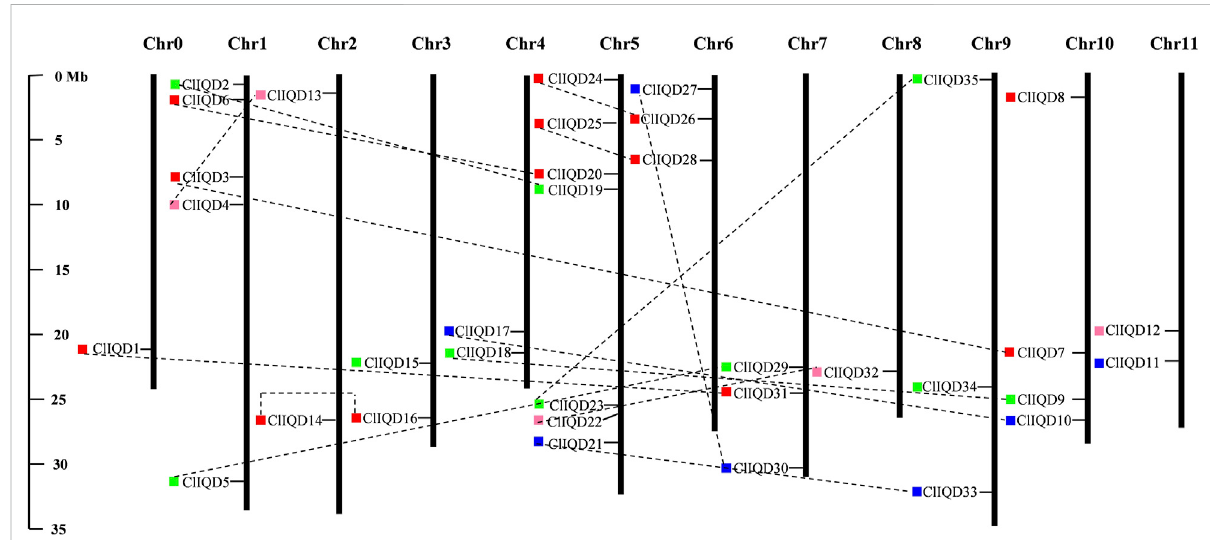
Chromosomal distribution and duplication events of watermelon IQD genes. The 35 ClIQD genes are widely mapped to the 11 watermelon chromosomes. Duplicated paralogous pairs of ClIQD genes in segmentally duplicated blocks are connected with black dashed lines.